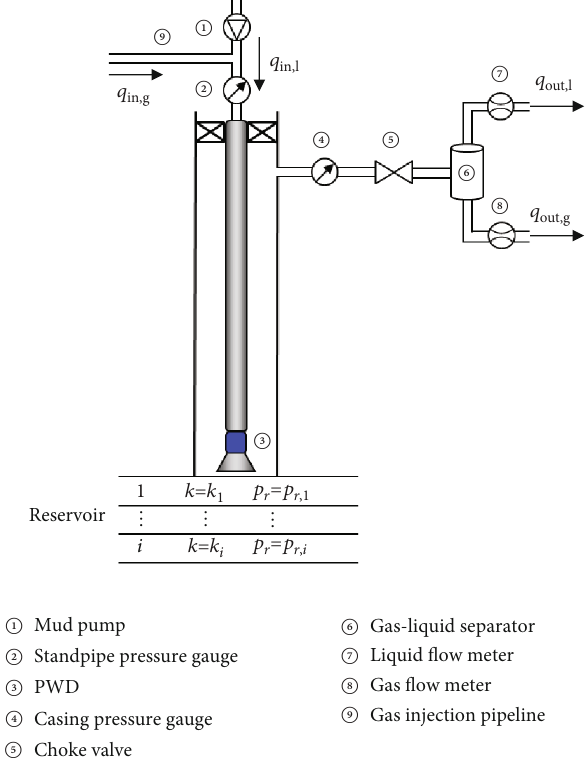
Figure 2: Diagram of underbalanced drilling of gas injection in the drill